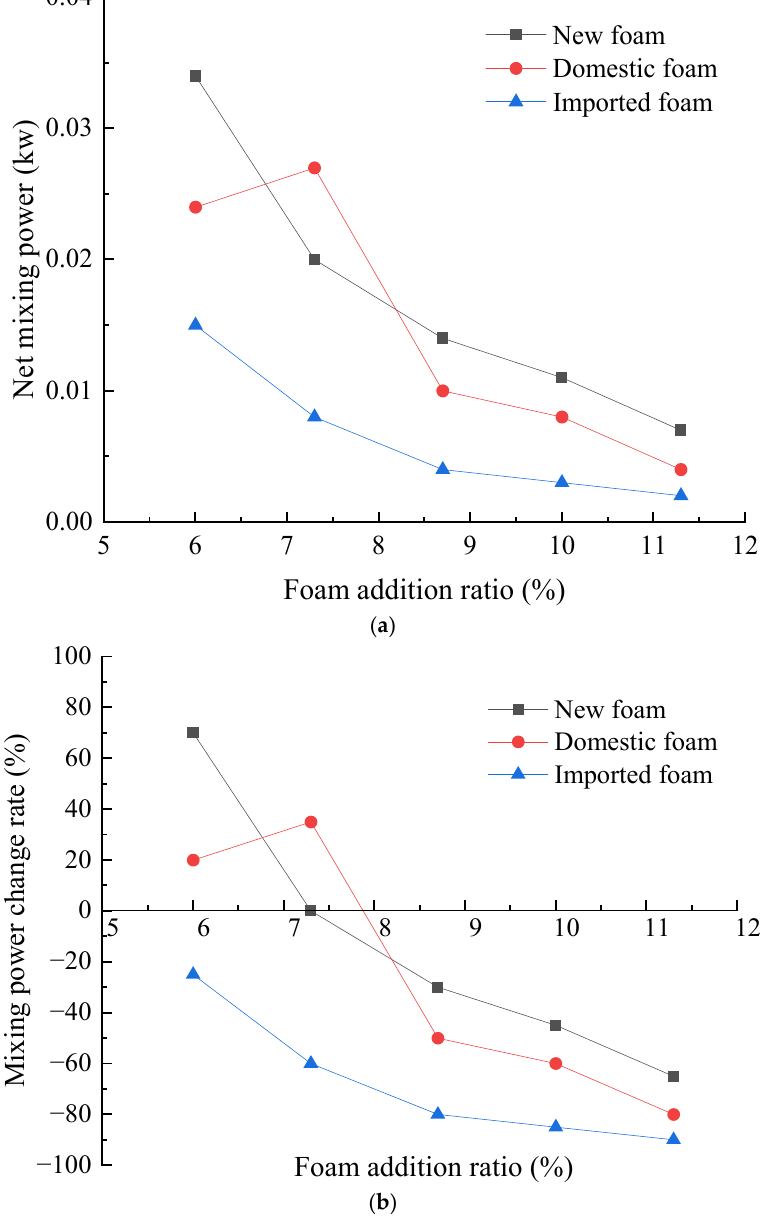
Figure 12. Comparison of net mixing power and mixing power change rate of sand improved by different foam agents. ( a ) Mixing power change curve. ( b ) Change curve of the mixing power change rate.